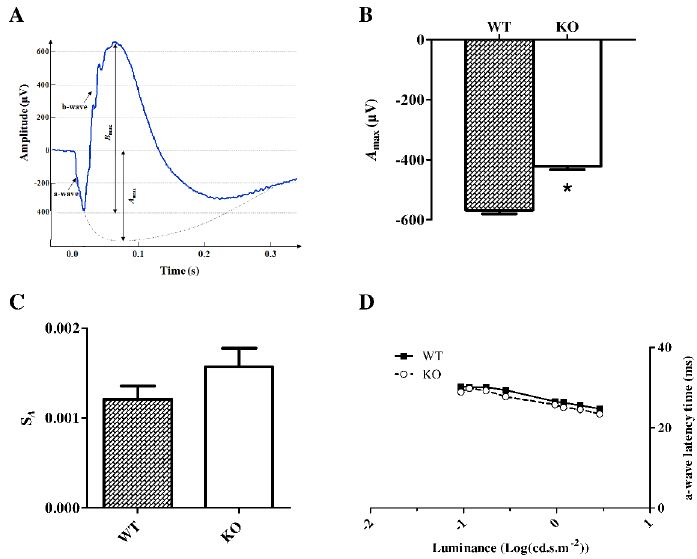
Figure 2. Scotopic a-wave characteristic in WT and Fmr1 KO mice. Retinal function was evaluated using to ElectroRetinoGram (ERG) (n=20 for WT and n=17 for Fmr1 KO). For each ( A ) typical ERG obtained at light intensity 2 2.88 log(cd.s.m 2 2 ), the decreasing part of the a-wave is fitted to calculate the extrapolated ( B ) maximal a-wave amplitude ( A max ) and ( C ) S A parameter reflecting the photoreceptor sensitivity. In Fmr1 KO mice compared to WT mice, A max is significantly decreased by 26% (p , 0.05), and the S A parameter is not significantly different (p=0.08). ( D ) a-wave latency was not different between groups. Data are presented as Mean 6 SEM. Student’s t test, *p , 0.05.